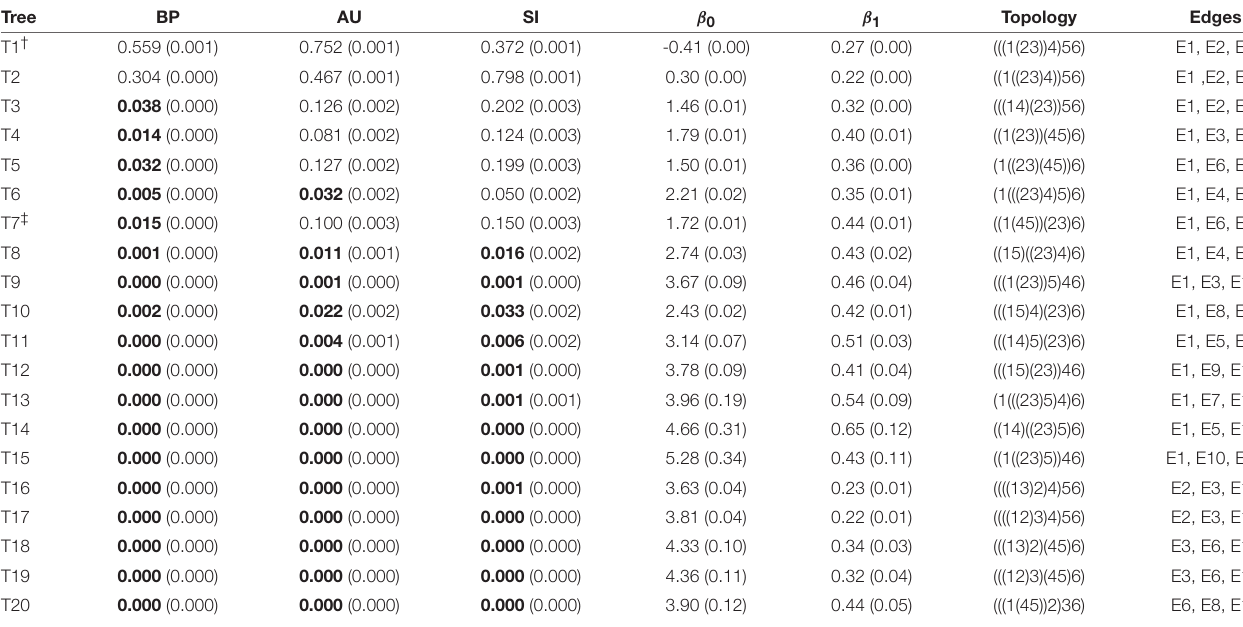
Standard errors are shown in parentheses. Boldface indicates significance (p < 0.05 ) for the null hypothesis that the tree is true (outside mode). For the rest of trees (T21 , ... , T105), p-values are very small (p < 0.001 ). † T1 is the ML tree, i.e., the tree selected by the ML method based on the dataset of Shimodaira and Hasegawa (1999). ‡ T7 is presumably the true tree as suggested by later researches; see section 4.3.